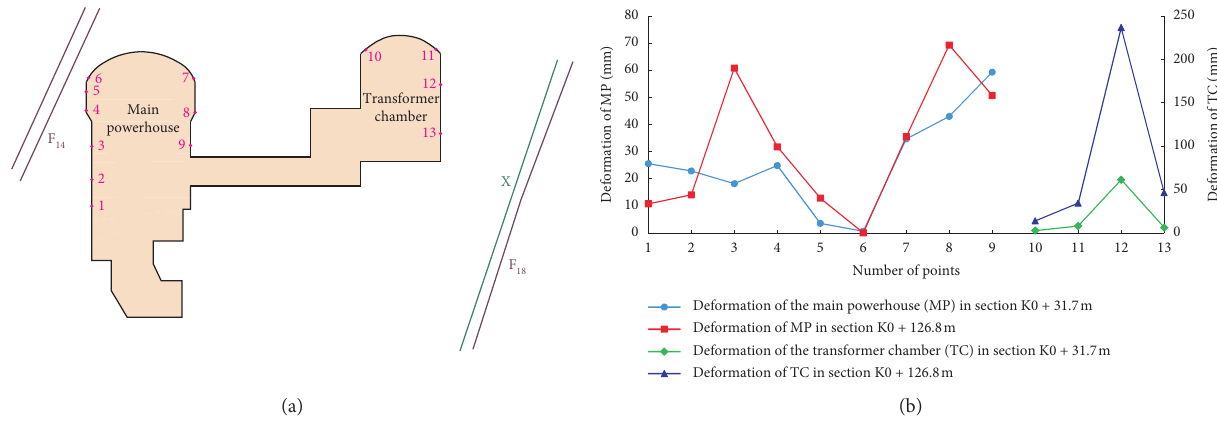
Figure 12: (a) Thirteen points for measuring surrounding rock mass deformation after excavation in both section K0 +31.7m and section K0 +126.8m and (b) the measurement results.